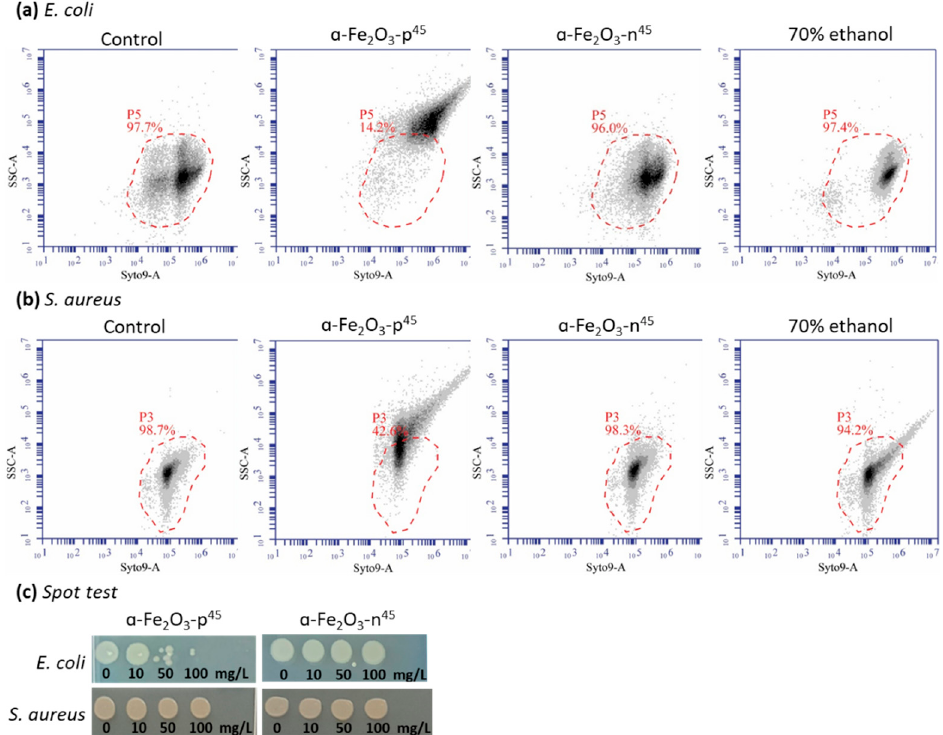
Figure 13. Quantification of hematite NPs binding to the bacteria Escherichia coli ( a ) and Staphylococcus aureus ( b ) by flow cytometry to determine the side-scattered (SSC) signal shift of Syto9-stained cells. Control cells-gated cell population is marked by the dashed red line. The spot test ( c ) shows that α -Fe 2 O 3 - p 45 NPs at 50 mg/L were toxic to E. coli but not to S. aureus , and α -Fe 2 O 3 - n 45 NPs were not toxic to both bacteria. After exposure to 70% ethanol for 60 min, the colony-forming ability of E. coli and S. aureus was not observed.